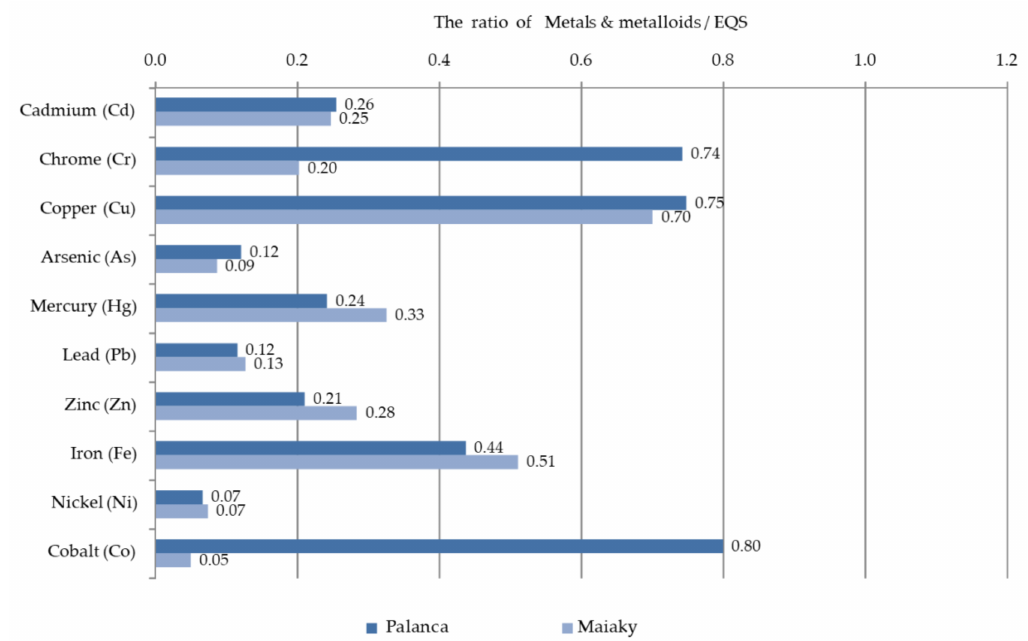
Figure 5. The ratio of the average concentrations of heavy metals and metalloids to their environmental quality standards (EQS) in bottom sediments in the lower reaches of Palanca and Maiaky of the Dniester